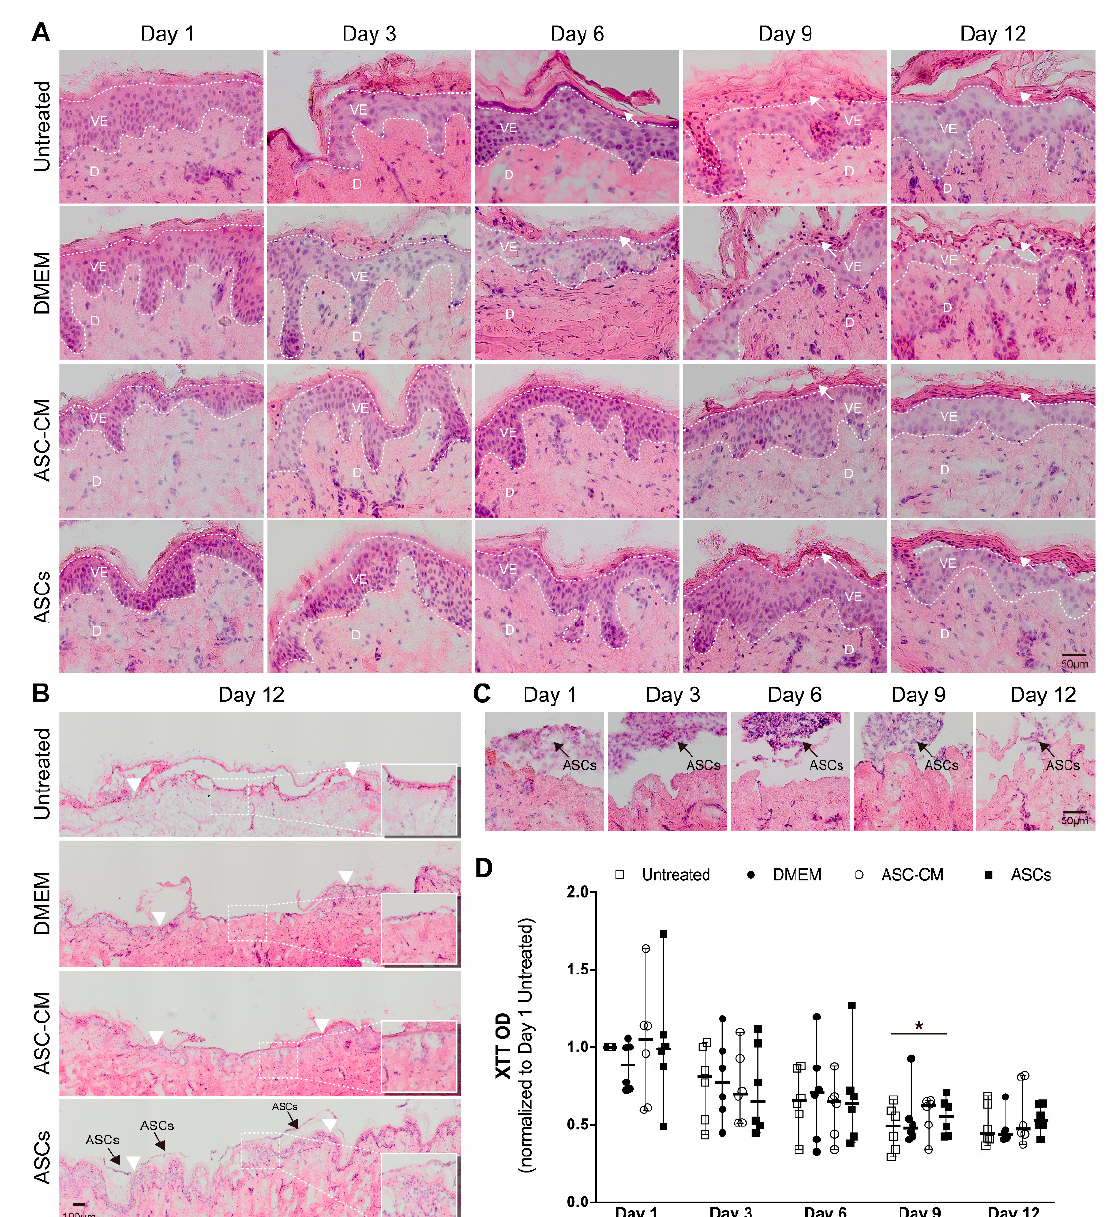
Figure 4. Skin morphology, re-epithelialization, and reductive activity of ex vivo skin samples at different time points during the treatment with DMEM, ASC-CM, and ASCs. ( A ) Representative images of H and E-stained skin sections showing the epidermis close to the wound edge. The white dotted lines show the viable epidermis, whereas the white arrows point to differentiated cells in the upper epidermis. All pictures were taken with the same magnification; scale bar, 50 µ m. VE, viable epidermis; D, dermis. ( B ) Representative images showing vertical sections of whole wounds after 12 days of culture. All pictures were taken with the same magnification; scale bar, 100 μ m. Insert images are two-fold magnifications of the boxed area. White arrowheads point to the former wound edges. Black arrows point to ASCs. ( C ) Images of ASCs treated wound area at each time point. Black arrow points to ASCs. All pictures were taken with the same magnification; scale bar, 50 μ m. ( D ) XTT assay ran with skin biopsies from six independent donors, showing the reductive activity of skin biopsies. Reported values are normalized with respect to the negative control group at day 1. Median and range values are also depicted. The Wilcoxon signed-rank test was used for the statistical analysis. * p < 0.05.